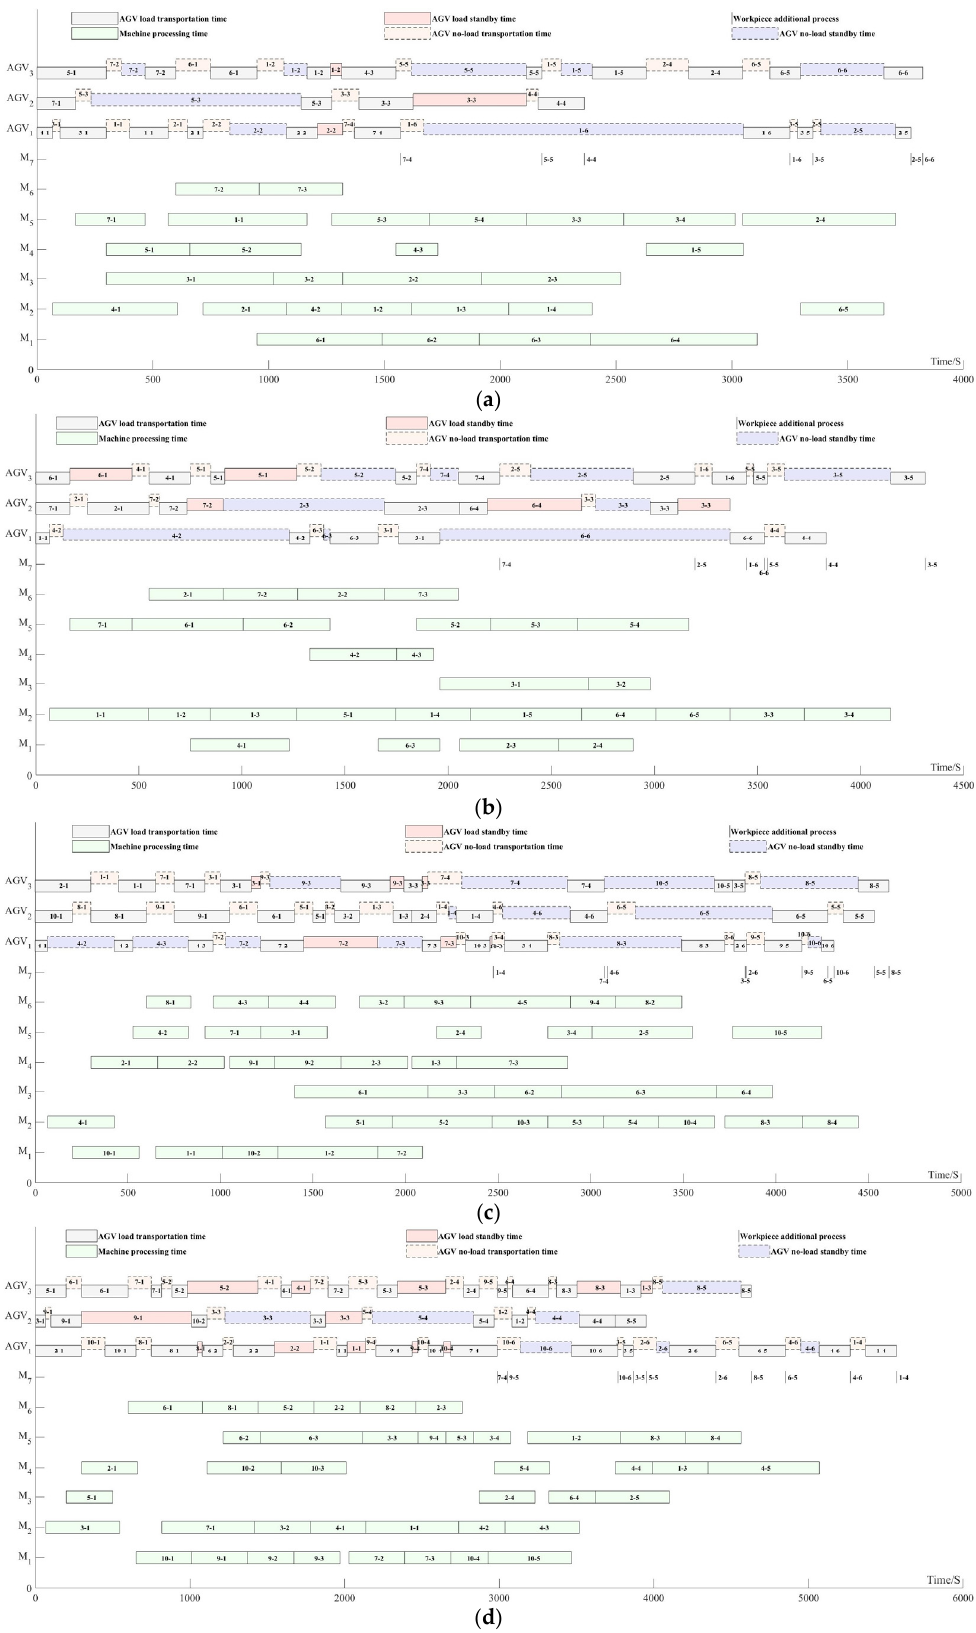
Figure 9. The Gantt charts of optimization results. ( a ) EDA-LSHS for product 1; ( b ) EDA for product 1; ( c ) EDA-LSHS for product 4; ( d ) EDA for product 4.